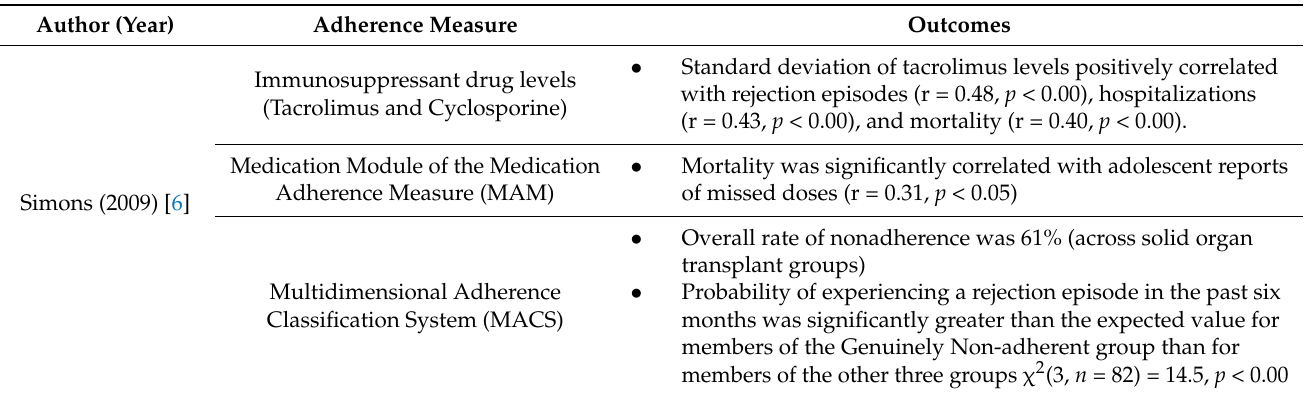
Table 3. Studies exploring drug levels as a marker for nonadherence and